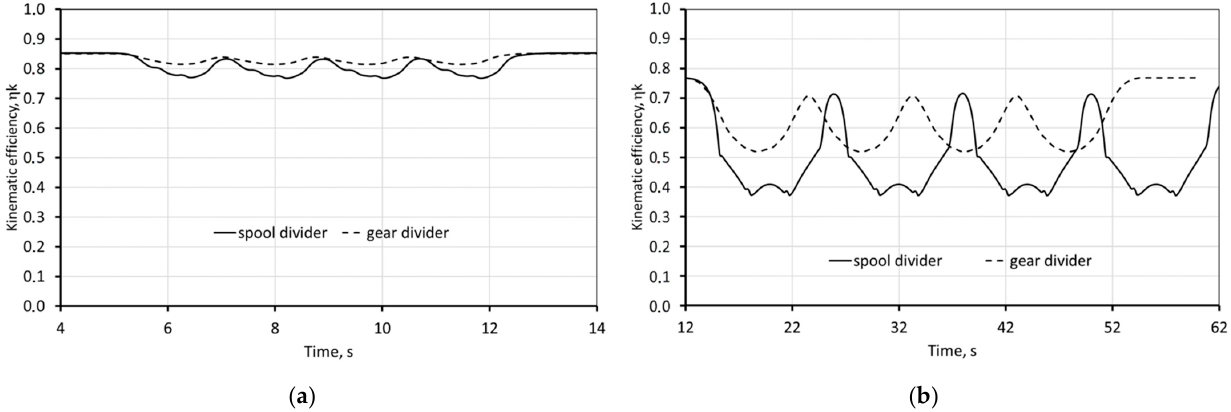
Figure 18. Pump pressure with nominal pump flow ( a ) and 25% of nominal pump flow for spool and gear-type flow dividers.